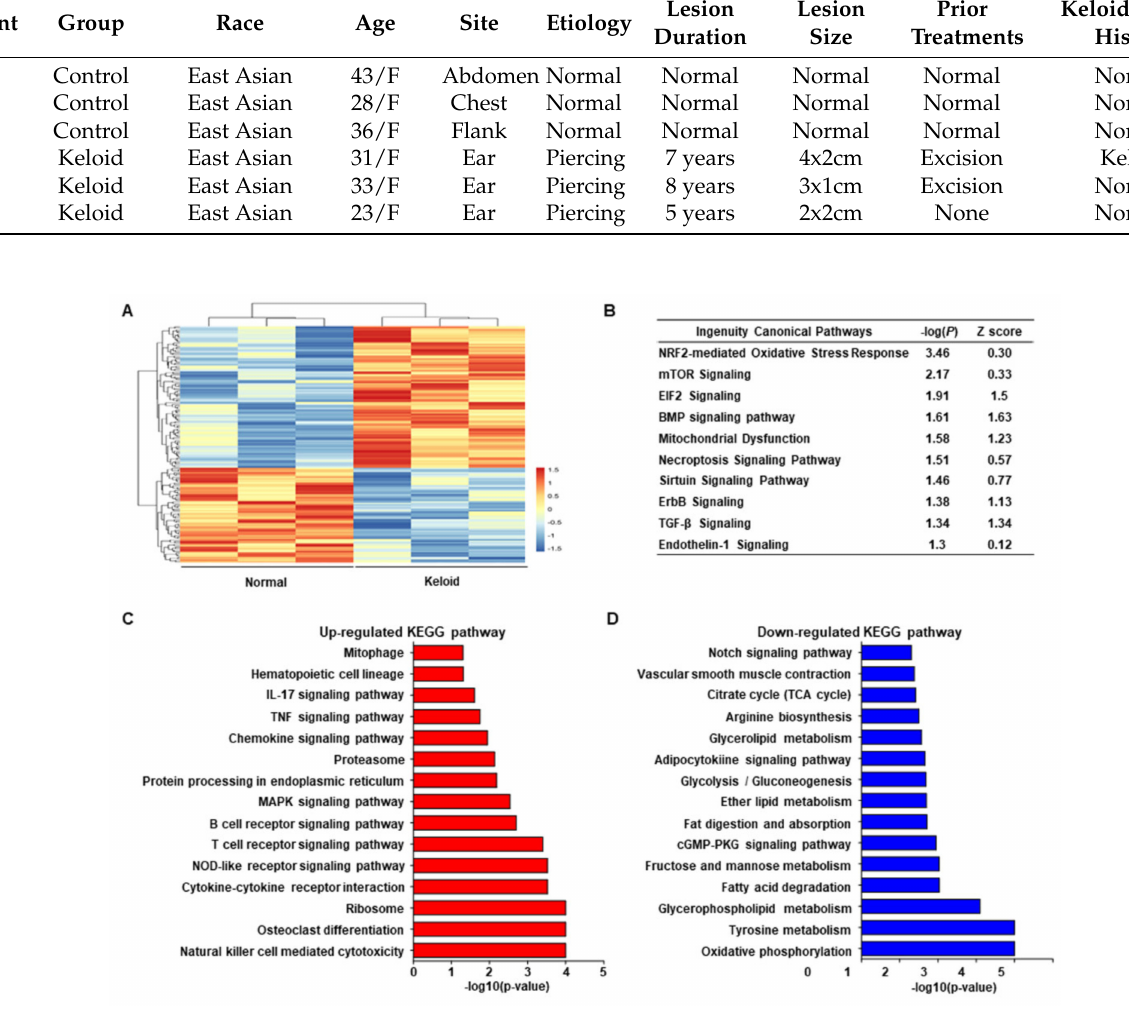
Figure 1. Transcriptomic analysis in keloid skin and normal skin ( n = 3 for each group). ( A ) Repre–sentative heatmap image of differential gene expressions between keloid skin and normal skin. ( B ) Upregulated pathway in keloid using ingenuity pathway analysis (IPA). ( C ) Upregulated Kyoto Encyclopedia of Genes and Genome (KEGG) pathways in the keloid group compared to the normal group ( p < 0.05). ( D ) Downregulated KEGG pathways in the keloid group compared to the normal group ( p <